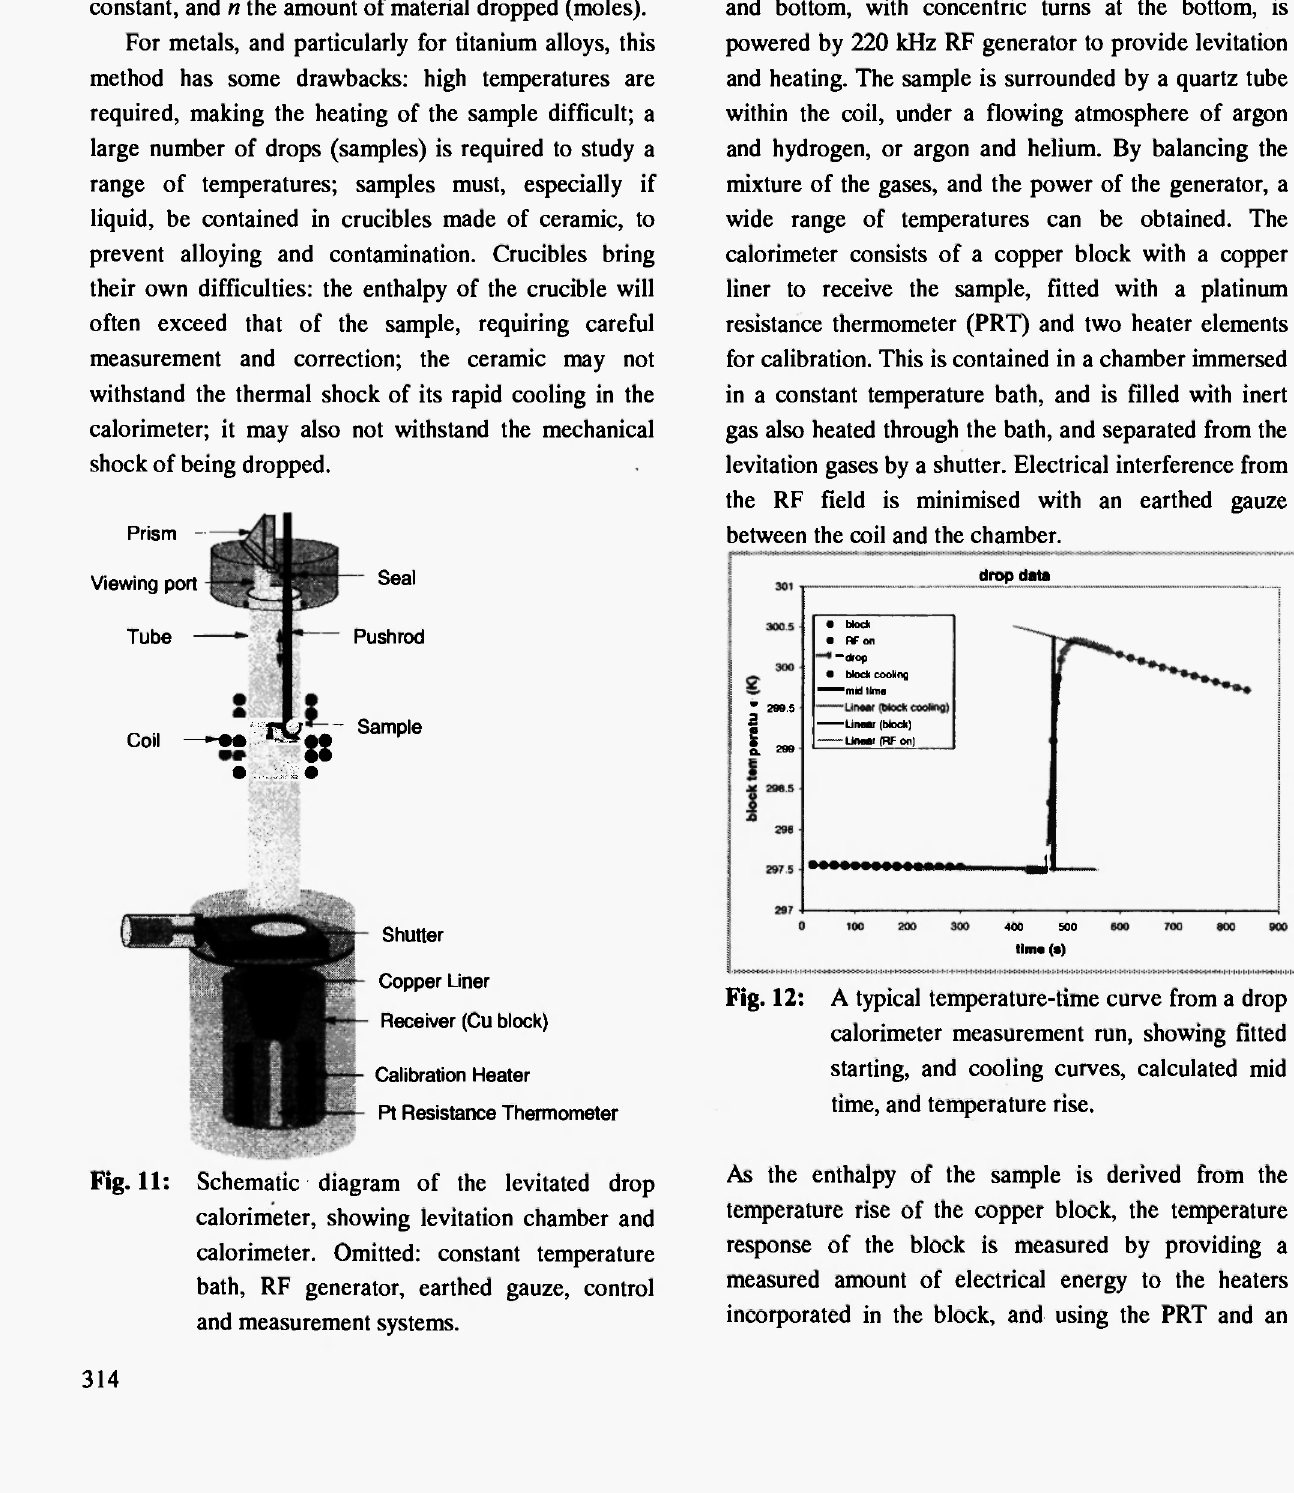
Fig. 12: A typical temperature-time curve from a drop calorimeter measurement run, showing fitted starting, and cooling curves, calculated mid time, and temperature